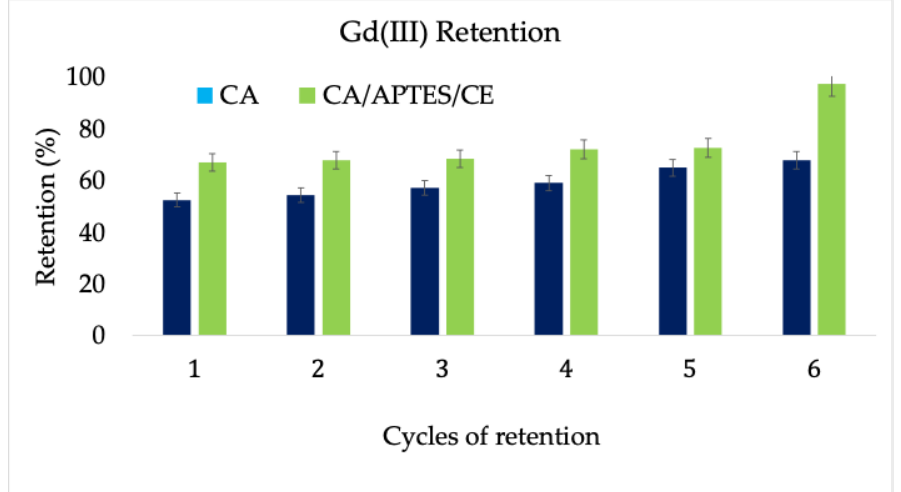
Figure 7. Retention of Gd (III) through the cellulose acetate control membrane and through the membrane functionalized with crown ether. The errors were calculated using 5 membranes to evaluate the homogeneity of the materials obtained.